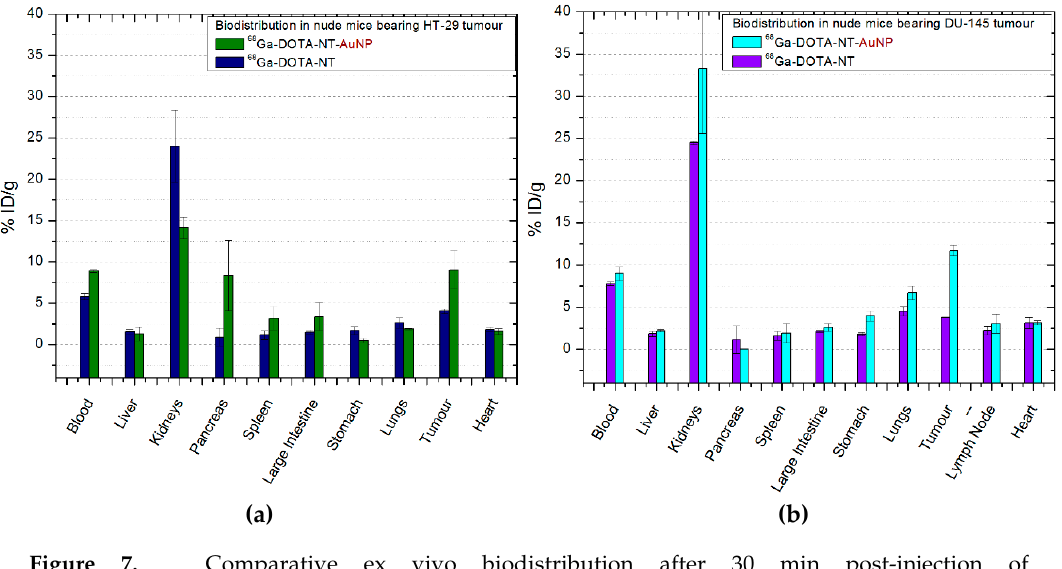
Figure 7. Comparative ex vivo biodistribution after 30 min post-injection of 68 Ga-DOTA-NT / 68 Ga-DOTA-NT-AuNP: ( a ) in nude mice bearing colon tumour; ( b ) in nude mice bearing prostate tumour. Data are presented as mean ± SD ( n = 4).